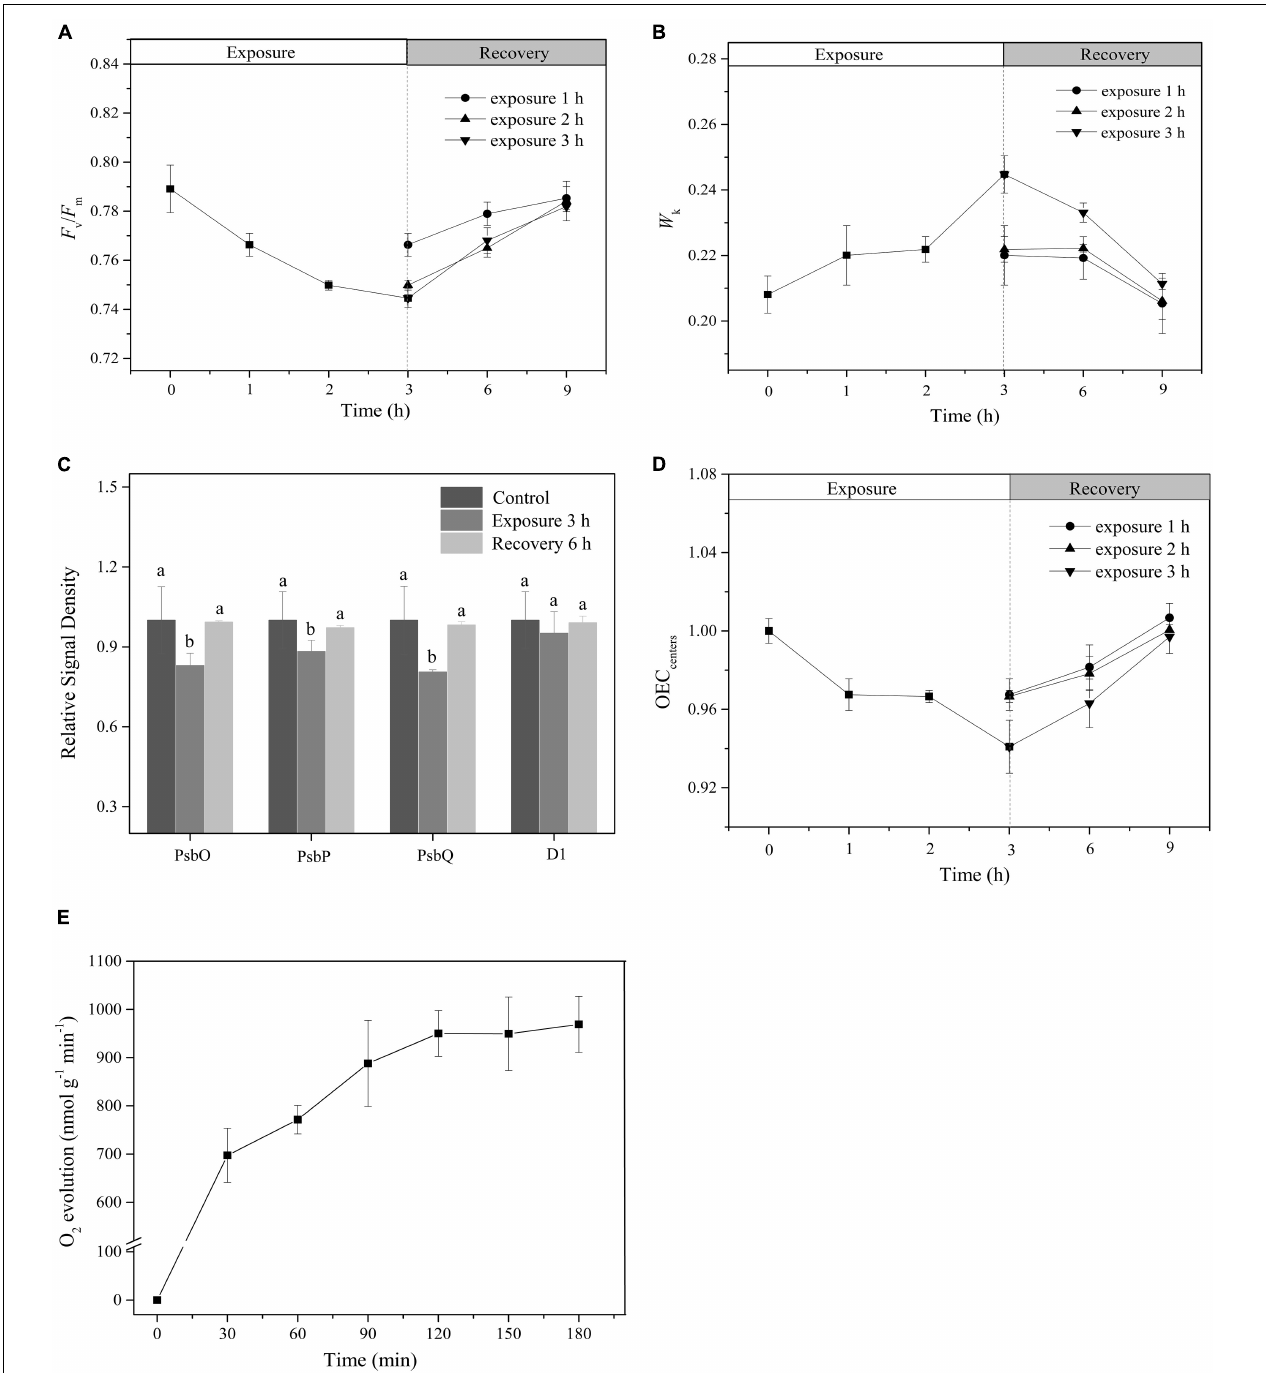
FIGURE 3 | The recovery of photoinactivated OEC. (A,B) Time course of changes in F v / F m and W K . White and light gray rectangles represent HL (400 µ mol photons/m 2 s) exposure and dark recovery period, respectively. Circle, triangle, and inverted triangle represent the different recovery start times: after HL exposure for 1, 2, and 3 h, respectively. (C) The relative expression levels of OEC peripheral proteins and PSII core D1 protein after 3 h HL exposure and subsequent 6 h recovery. The means ± SD were calculated from three independent samples. Different letters indicate a significant difference (Tukey’s tests, p < 0.05). (D) Time course of changes in OEC centers . White and light gray rectangles represent HL exposure and dark recovery period, respectively. Circle, triangle, and inverted triangle represent the different recovery start time: after HL exposure for 1, 2, and 3 h, respectively. (E) Changes in O 2 evolution rate. The means ± SD were calculated from three independent